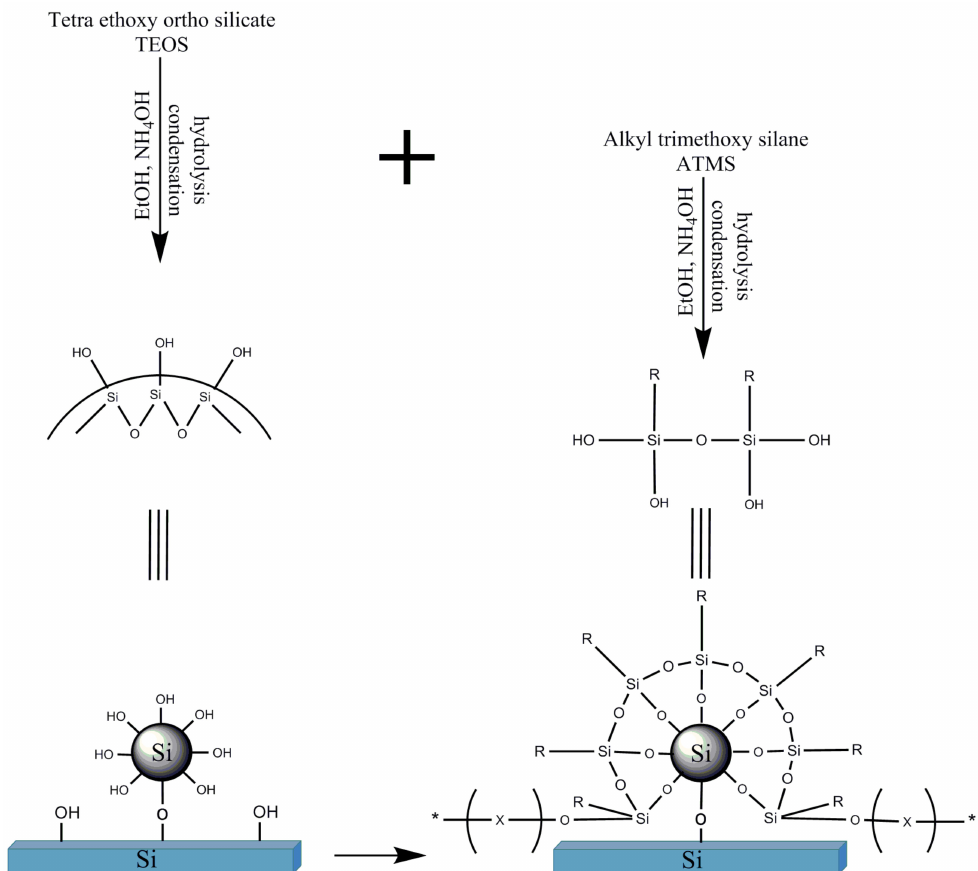
Figure 8. Proposed reaction